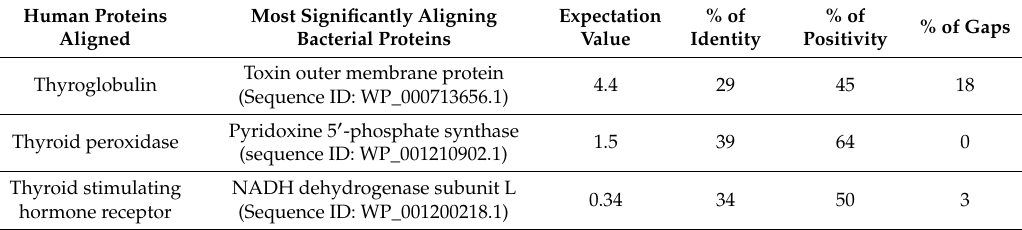
Table 3. Most significantly aligning sequences of each of the three human proteins tested for structural homology with H. pylori G27. “Expectation value” is the number of hits one would expect to occur merely by chance. “% of identity” represents the percentage of identical amino acids in the two compared sequences”. “% of positivity” means the percentage of residues in the two aligned sequences that are very similar to each other. “% of gaps” mean the percentage of intervals lacking linear homology between two homologue sequences.